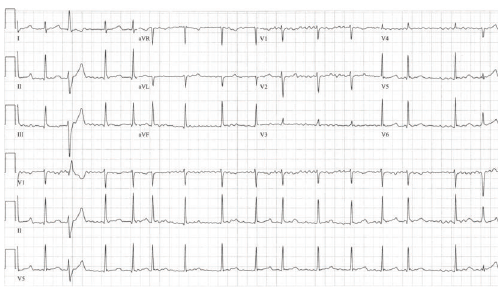
Figure 1: ECG at presentation revealing atrial fibrillation and intermittent premature ventricular contractions. Ventricular rate of 65–150 bpm.